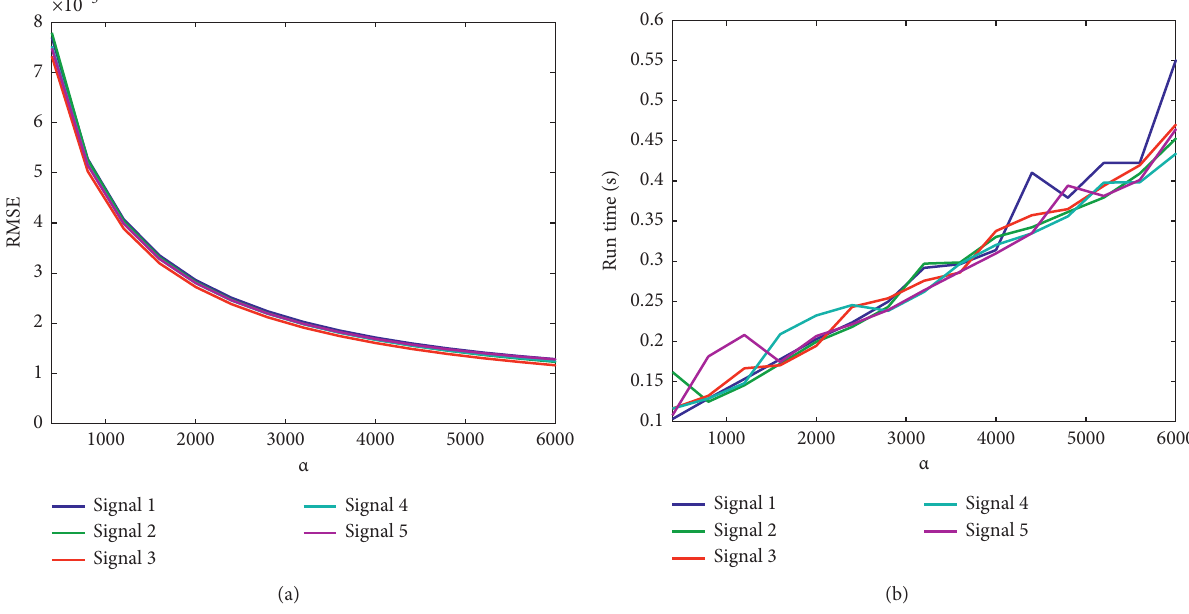
Figure 3: The processing results of different low-frequency noises. (a) RMSE. (b) Running time.